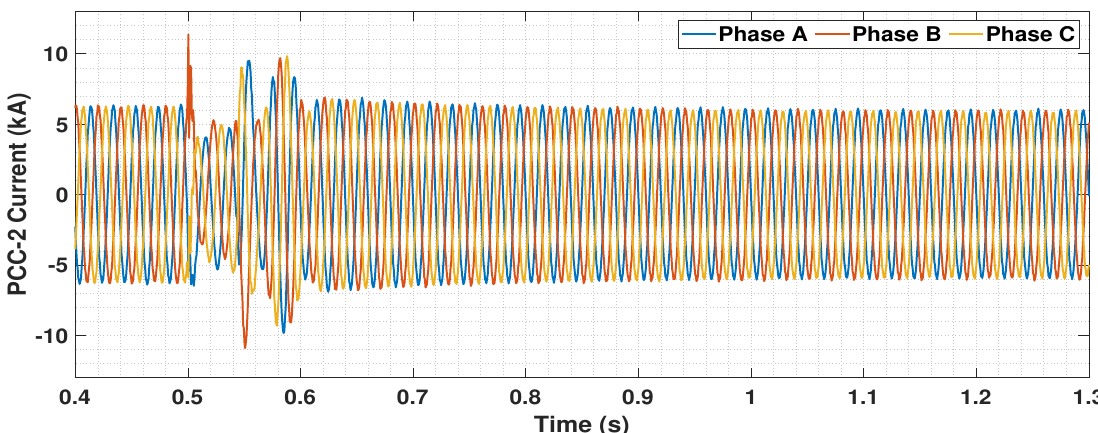
Figure 38. Currents in PCC-2 upon three-phase line to ground fault in the middle of